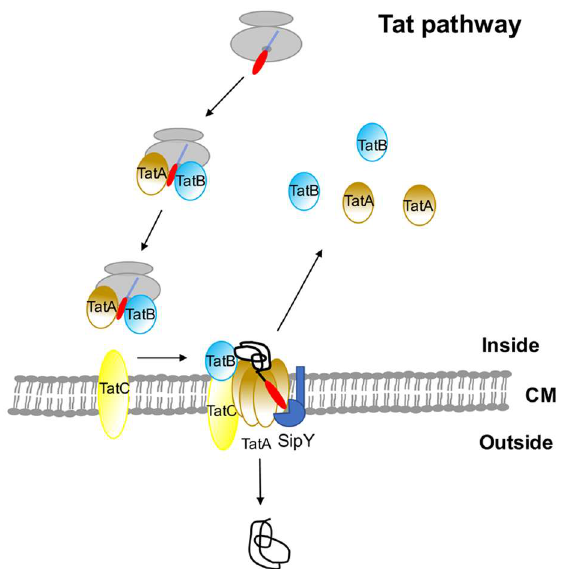
Figure 2. Streptomyces lividans minor secretory route (Tat pathway). The nascent secretory pre-protein using the Tat route is thought to be targeted to the membrane by the heterodimeric TatA-TatB complex. The signal peptide is cleaved by the signal peptidases (exemplified by the major signal peptidase, SipY) before releasing the mature protein to the cell wall.